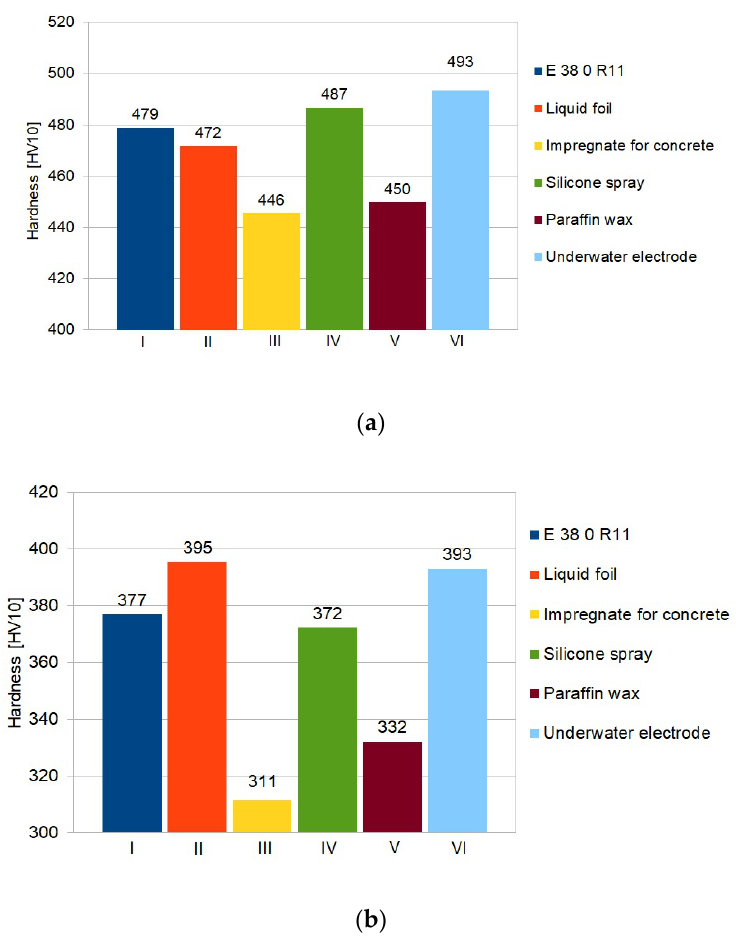
Figure 8. Average values of hardness HV10, I-VI means specimens group (Table 3), ( a ) in HAZ; ( b ) in weld.